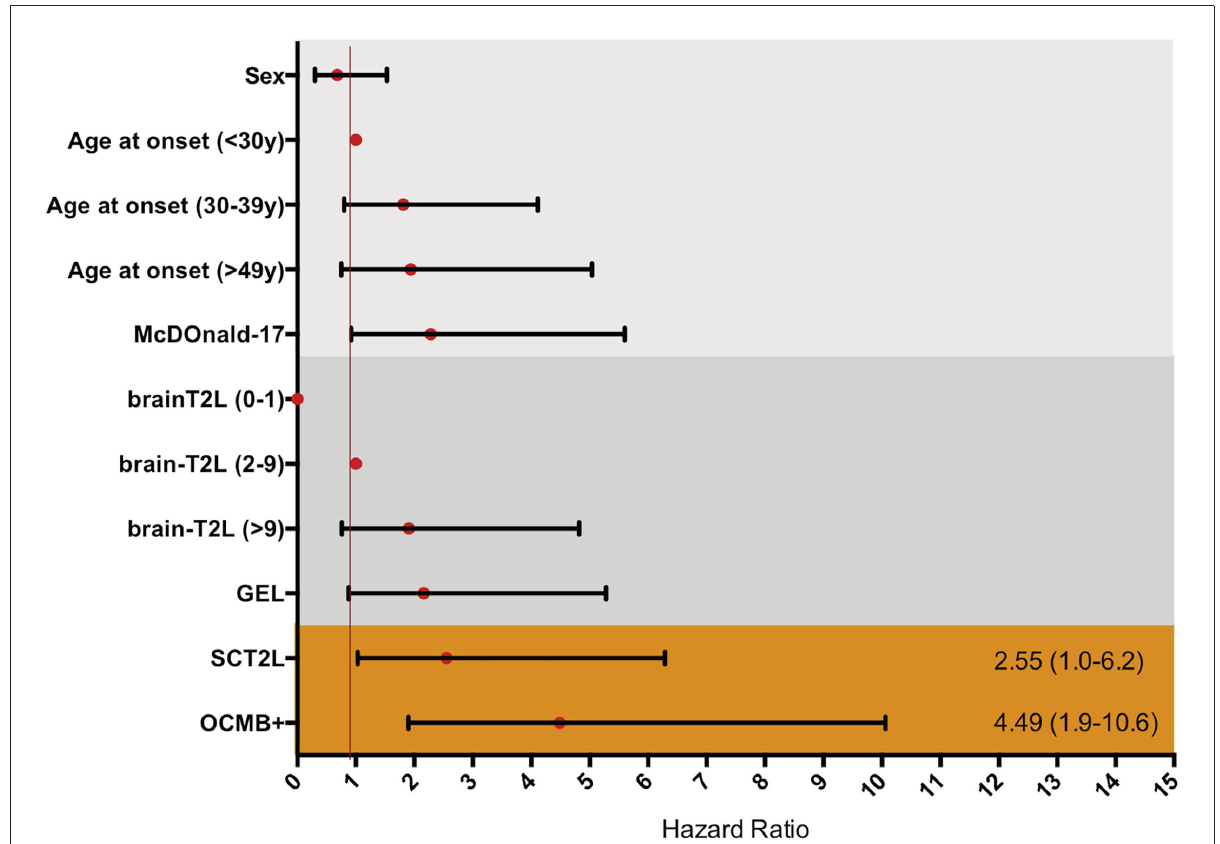
FIGURE5 Multnivariate Cox proportional hazard ratio adjusted by sex and age, for each of the possible informative variables. McDonald-17, fulfillment of McDonald 2017 criteria at presentation; BrainT2L, brain T2 lesion; GEL, gadolinium enhancing lesion; SCT2L, presence of cervical spinal cord T2 lesion; OCMB + , presence of oligoclonal M